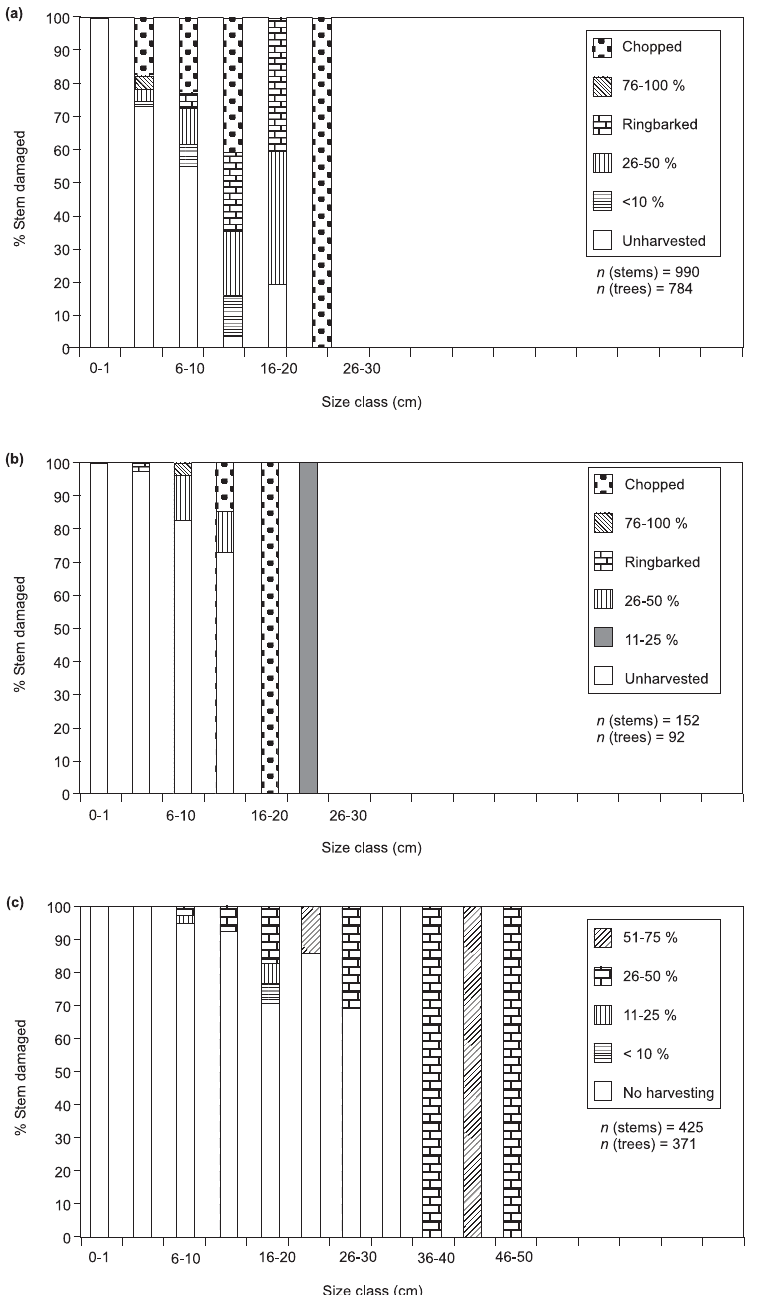
Fig. 4(a-c). Degree of stem damage to harvested Catha edulis through harvesting of bark below 2 m on the stem, and chopping of stems in populations situated (a) adjacent to a village near Barberton; (b) approximately 3 km from the village; (c) on a forestry plantation near